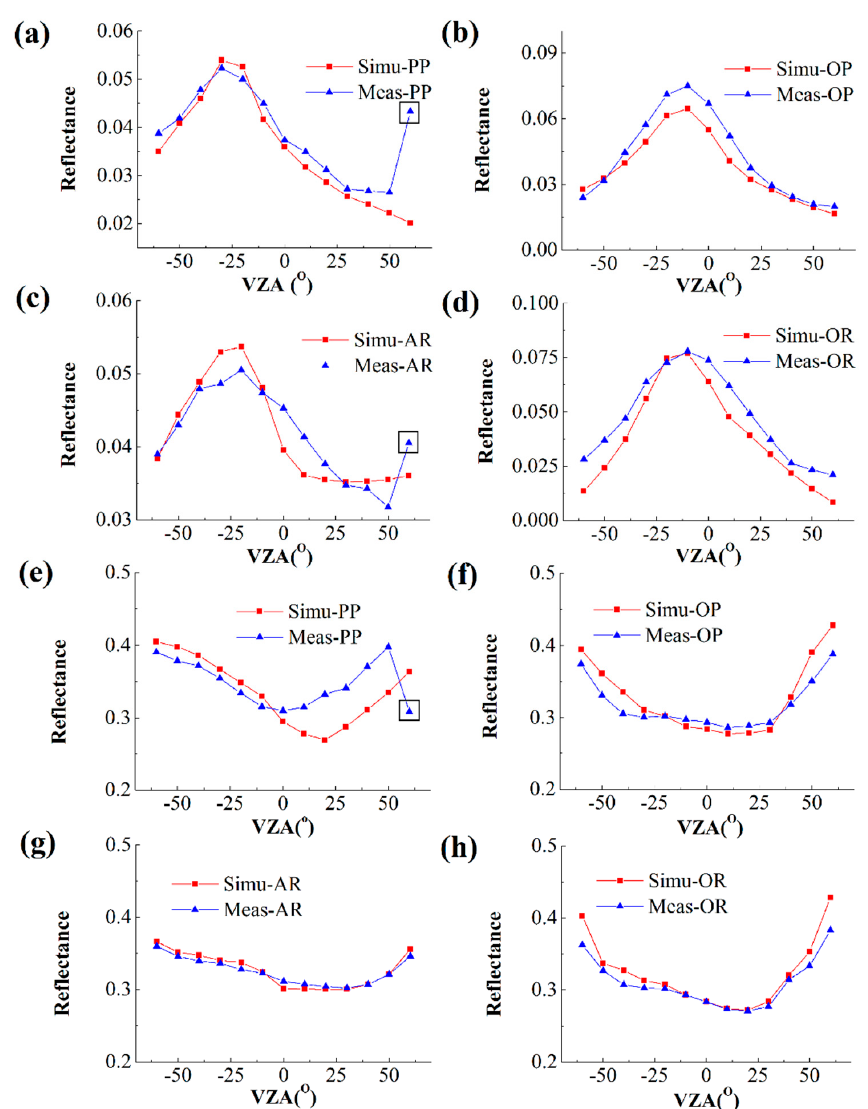
Figure 11. Comparison of the distribution of the sum of the reflectance simulated by the row model and field data in the multiangle observation for the principal plane (PP) mode ( a , e ), orthogonal plane (OP) mode ( b , f ), along-row plane (AR) mode ( c , g ), and orthogonal row plane (OR) mode ( d , h ). ( a – d ) Red band (670 nm); ( e – h ) NIR band (860 nm). VZA is the viewing zenith angle. The black box is the abnormal point in the measurement.